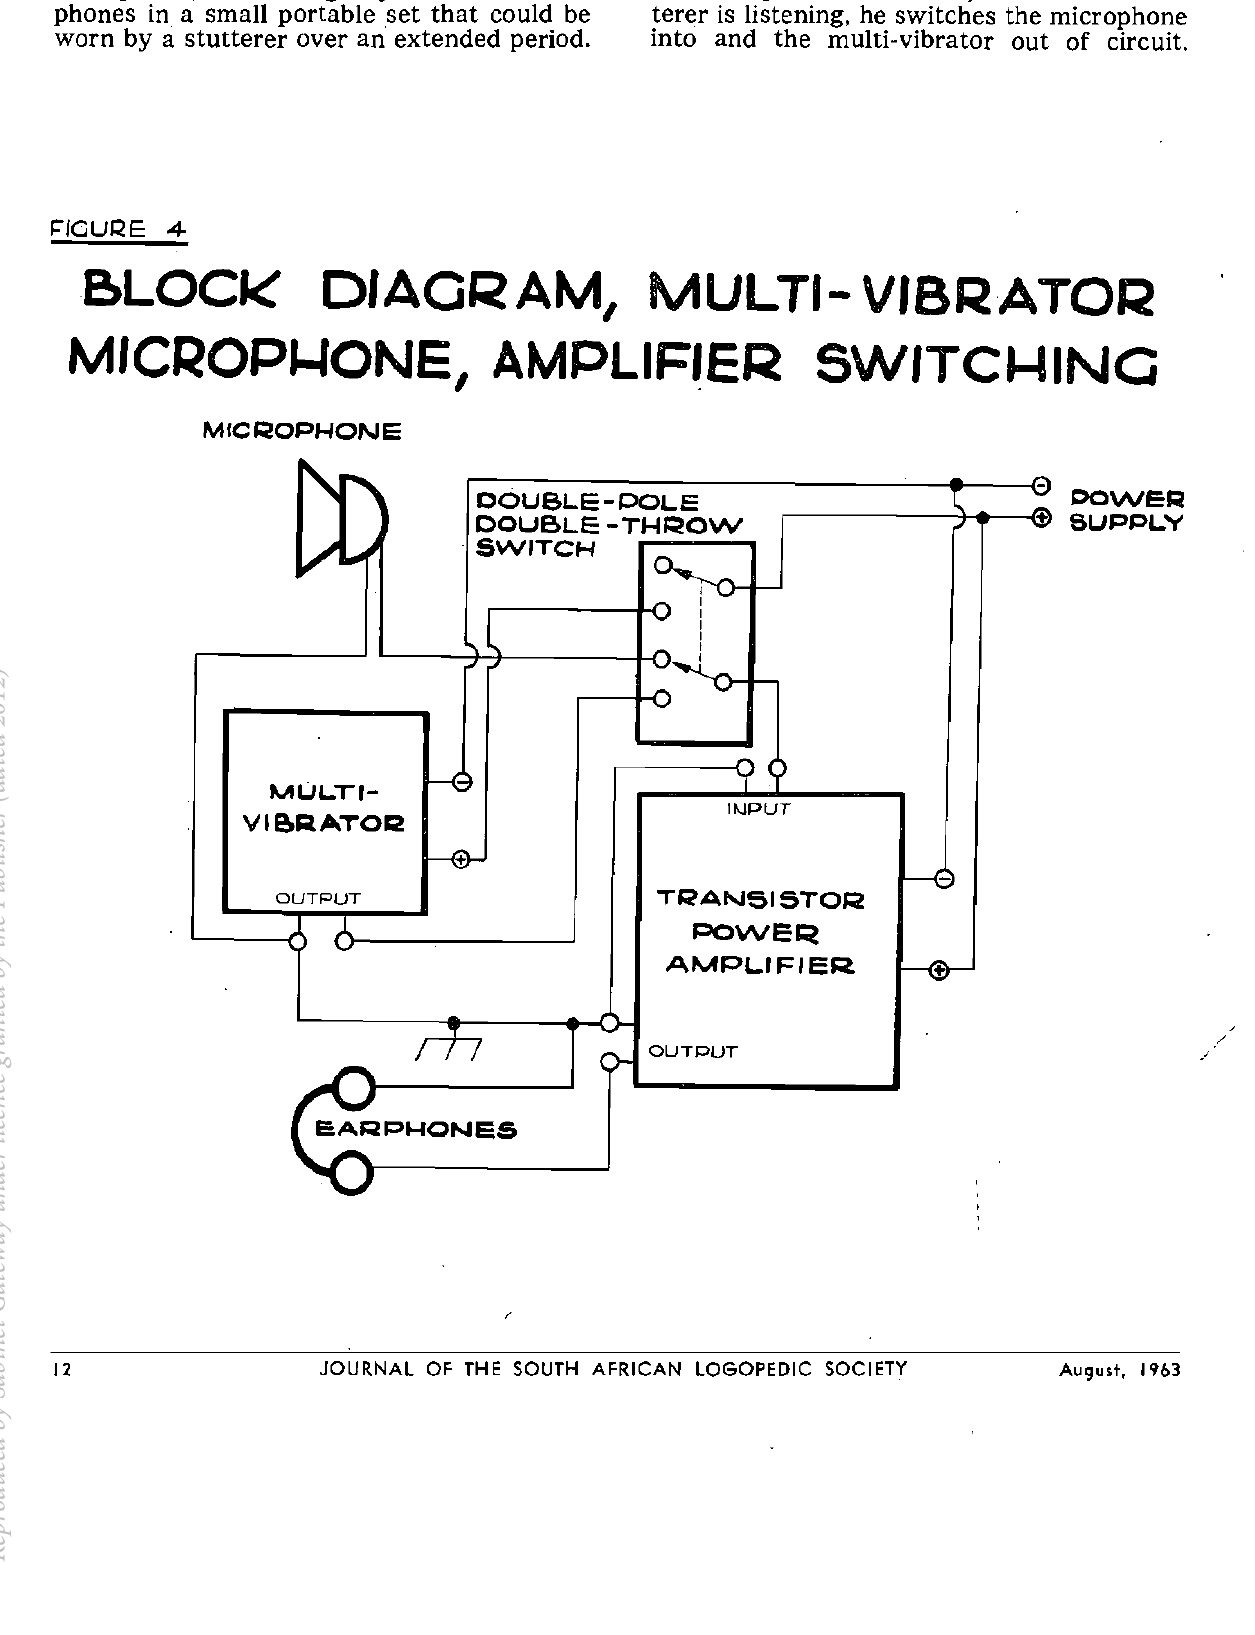
BLOCK: DIAGRAM, MULTI-VIBRATOR MICROPHONE,